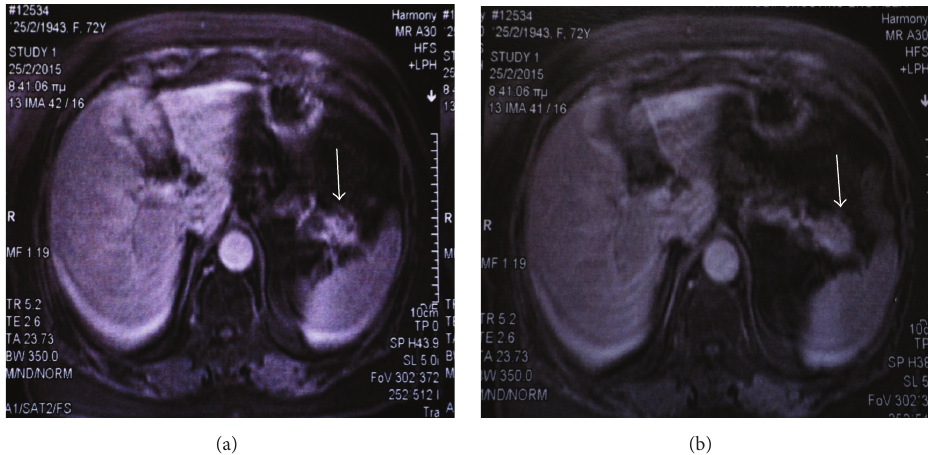
Figure 1: A mass in the tail of the pancreas with (a) strong enhancement and with (b) rapid washout, MRI images.